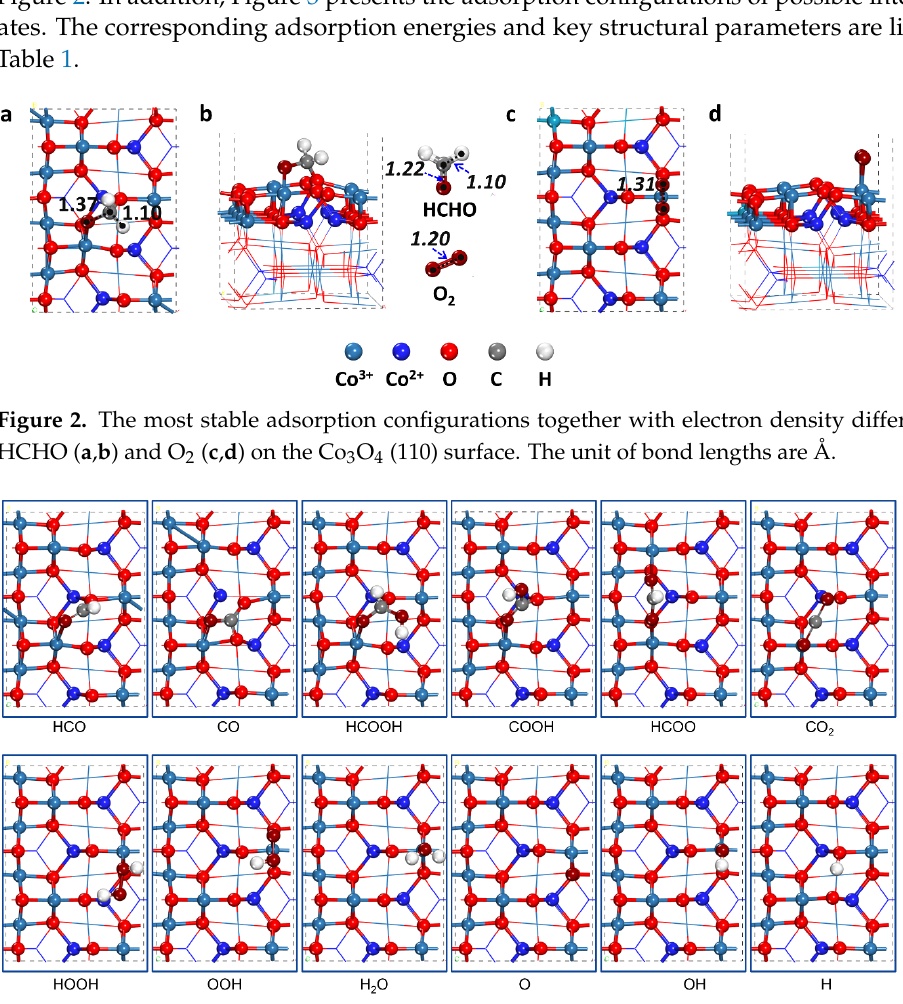
Figure 3. The most stable adsorption configurations of possible intermediate species involved in HCHO oxidation to CO 2 and H 2 O on Co 3 O 4 (110) surface.